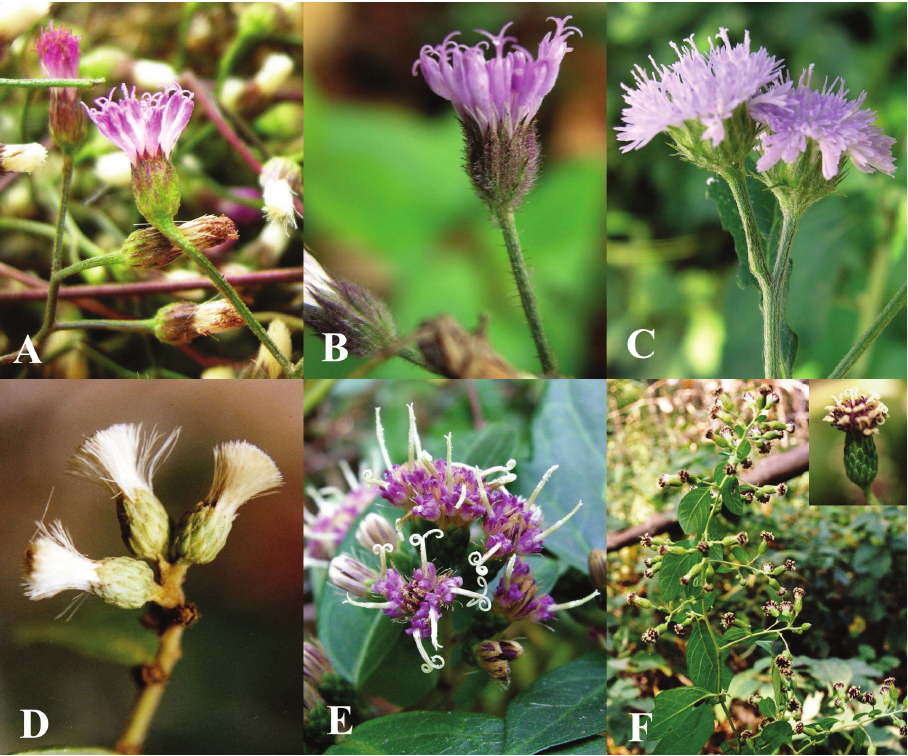
Figure 7. Morphology of Vernonieae in Thailand 3. A Cyanthillium cinereum B Cyanthillium montanum C Cyanthillium patulum D Decaneuropsis cumingiana E Decaneuropsis eberhardtii F Decaneuropsis garrettiana.